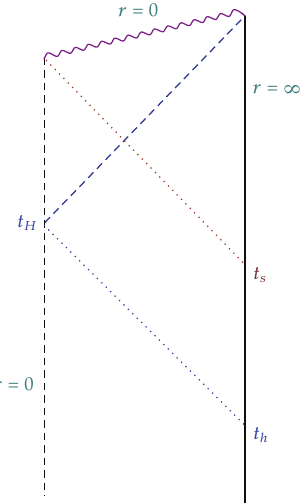
Figure 8: Penrose diagram for collapse in AdS. The vertical solid line represents the AdS boundary, the vertical dashed line the AdS origin, and the upper wavy curve the curvature singularity, produced by a null shell which originates on the boundary at time t s (cid:3) CFT dual of this process is discussed in Section 6.1.2 (cid:4) , and collapses to zero area. In the bulk, event horizon (cid:3) dashed diagonal blue line (cid:4) nucleates at bulk time t H , whose signal can be seen by bulk-cone singularity with one insertion at t h and the other at t (cid:7) ∞